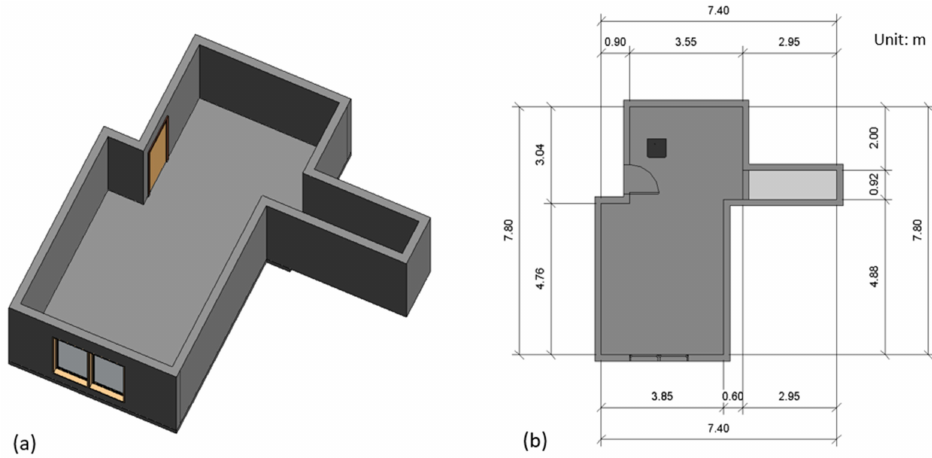
Figure 2. ( a ) 3D view of the selected room; ( b ) floor plan of the selected room (unit is